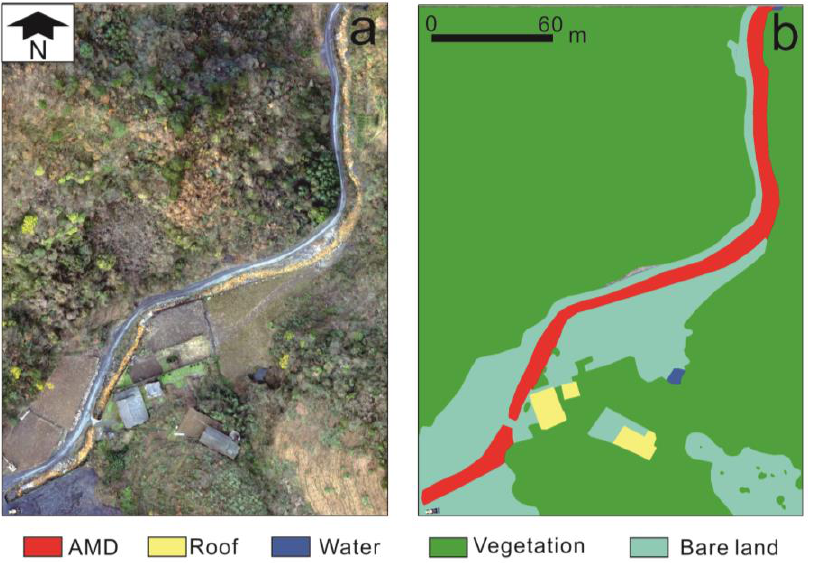
Figure 5. ( a ) The UAV image of the training area; ( b ) the ground truth of the training area.